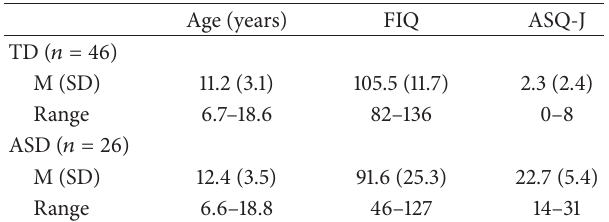
Table 1: Mean, standard deviation (SD) and range of chronological age, full intelligence quotient (FIQ), and scores on the Japanese ver- sion of the Autism Screening Questionnaire (ASQ-J) of participants in Experiment